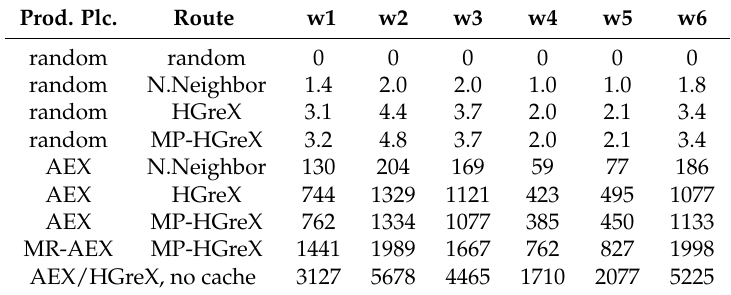
Table 5. The real running time of the optimization processes in seconds using a computer with two Xeon X5-2696-v2 CPUs, averaged over 10 optimization runs for the experimental data presented in Table 4 and additionally for AEX/HGreX without cache (see Section 5.4.2). Prod. Plc.